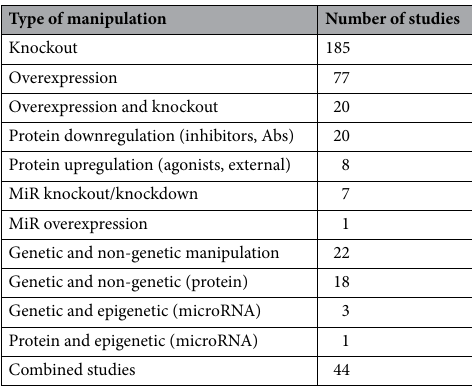
Table 1. Gene-specific manipulation types in bleomycin-induced lung fibrosis studies. For a full detailed list see Supplementary Table ST1.